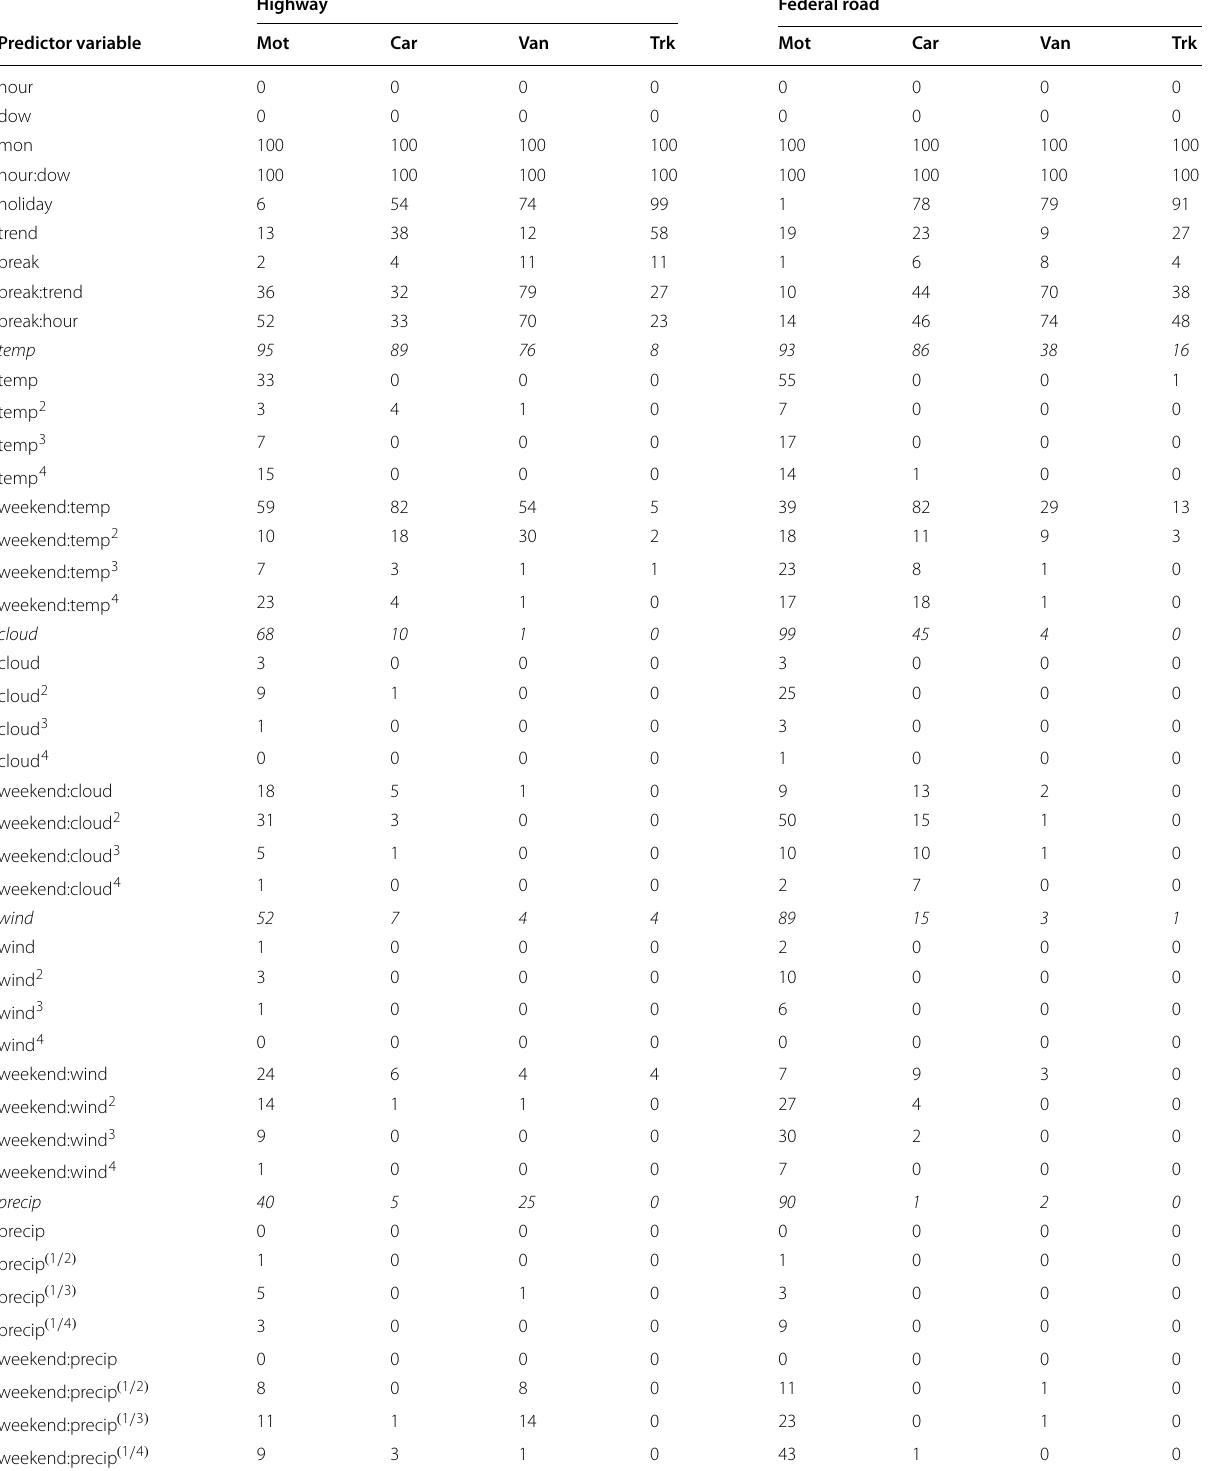
Table 4 Fraction of traffic stations (in percent) for which a predictor variable or interaction term is selected by the model selection procedure